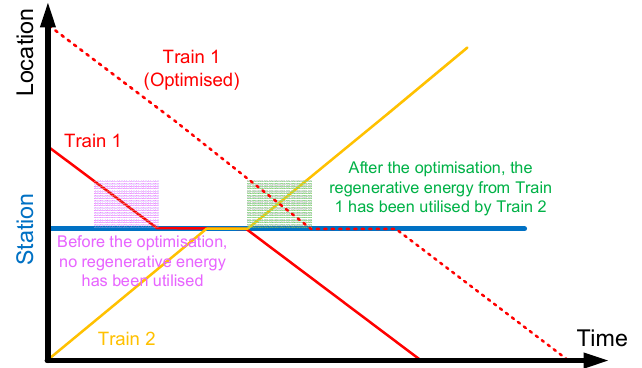
3 of 9 Table 1. Train movement modes. Movement Mode Equations Motoring